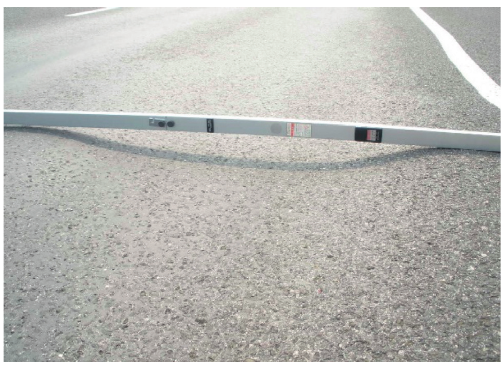
Figure 7: Result of the rutting survey at sample